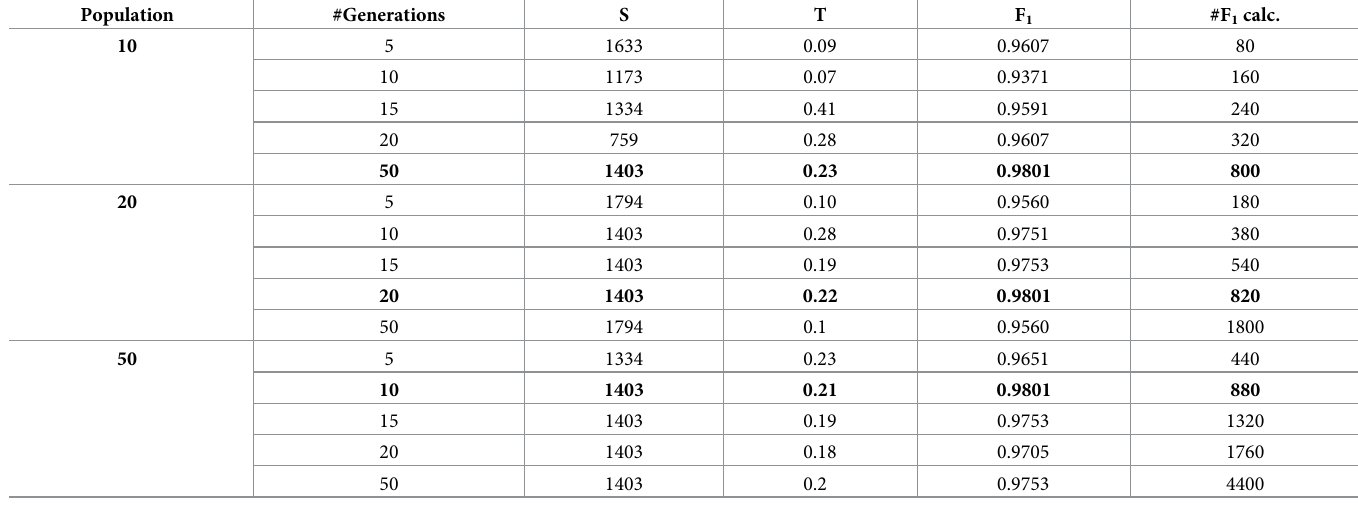
Table 5. GA results for different parameter